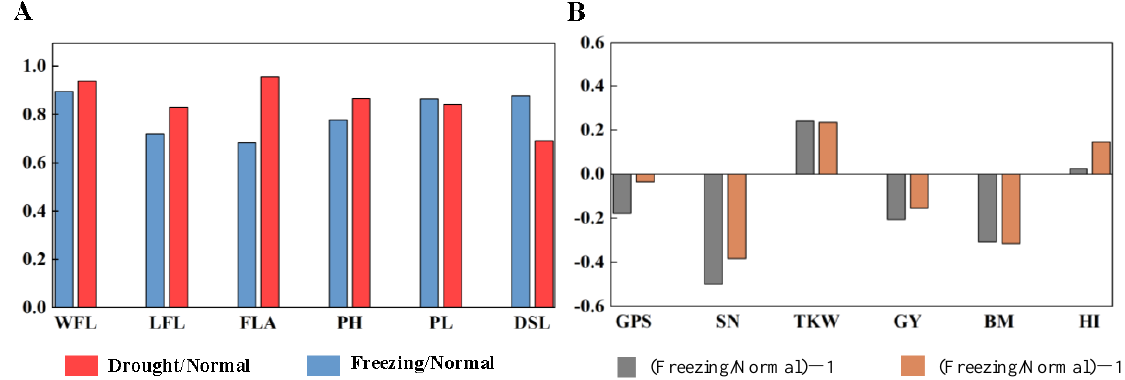
Figure 3. The effects of spring freezing and early drought on canopy structural traits ( A ) and yield traits ( B ) compared with the normal growing season. WFL: width of flag leaf; LFL: length of flag leaf; FLA: flag leaf area; PH: plant height; PL: peduncle length; DSL: distance from spike to leaves; GPS: grains per spike; SN: spike number per m 2 ; TKW: 1000-kernel weight; GY: grain yield; BM: biomass aboveground; HI: harvest index. Freezing/Normal, Drought/Normal: the ratio